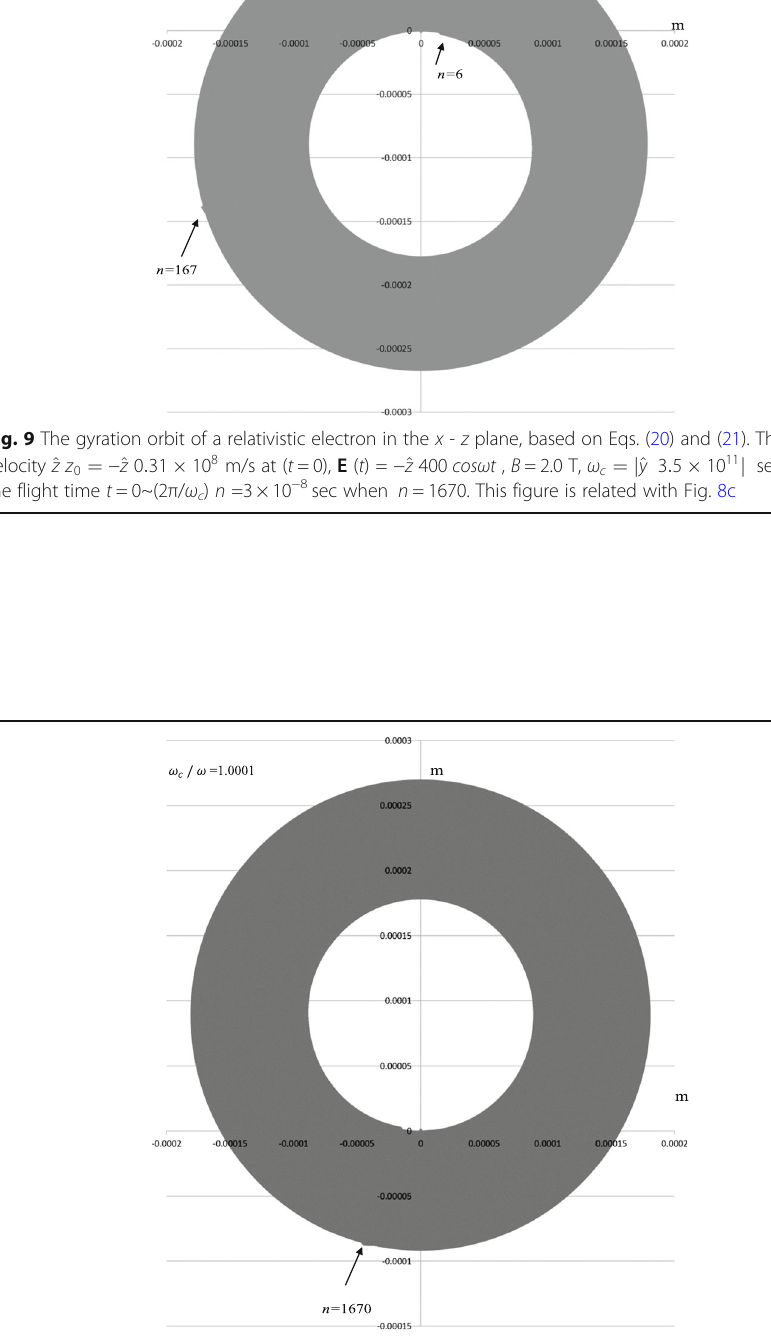
Fig. 10 The gyration orbit of a relativistic electron in the x - z plane. The physical conditions are the same with in Fig. 9, except for the following change of an initial velocity at ( t = 0): ^ z z 0 ¼ − ^ z 0 : 31 (cid:2) 10 8 → þ ^ z 0 : 3 1 (cid:2) 10 8 m/s. This figure is related with Fig.